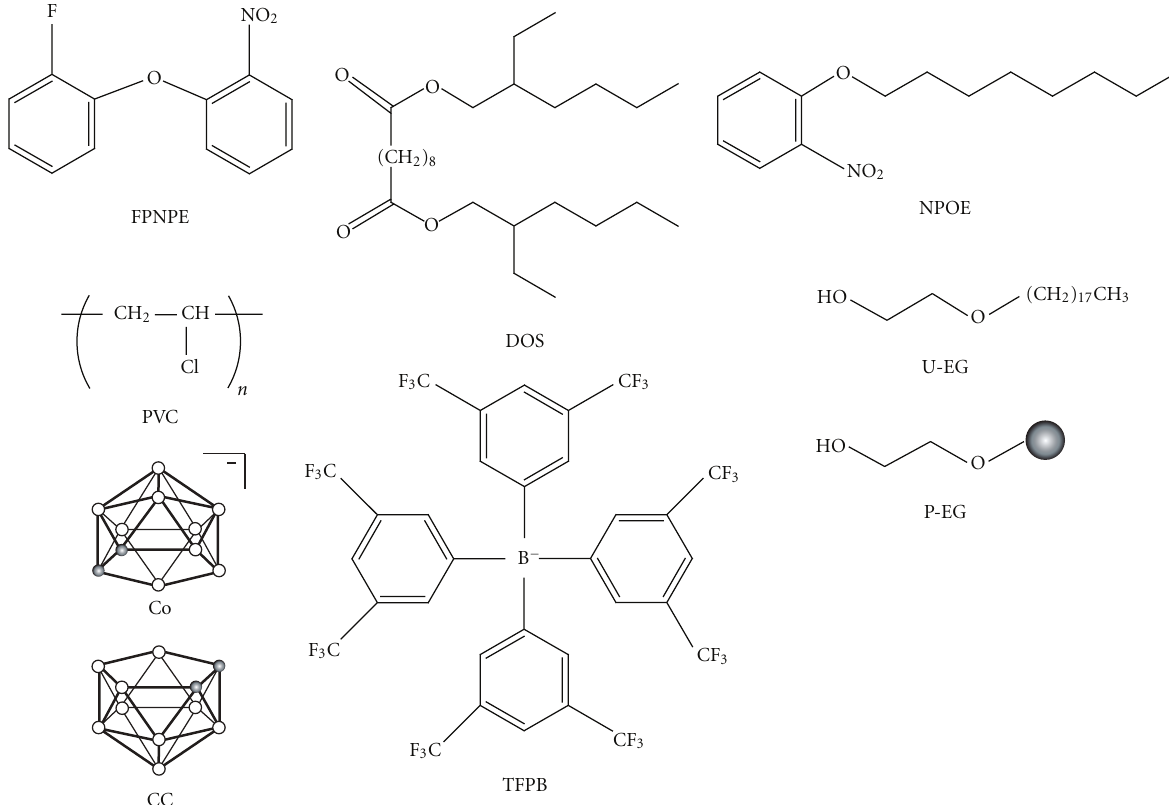
Figure 1: Chemical structures and nomenclature of the ion-selective membrane components used in this work. In the structure of cobalticarborane, open circles and shaded circles denote boron atoms and carbon atoms, respectively. The shaded circle in the structure of P-EG represents a cross-linked polystyrene microsphere.